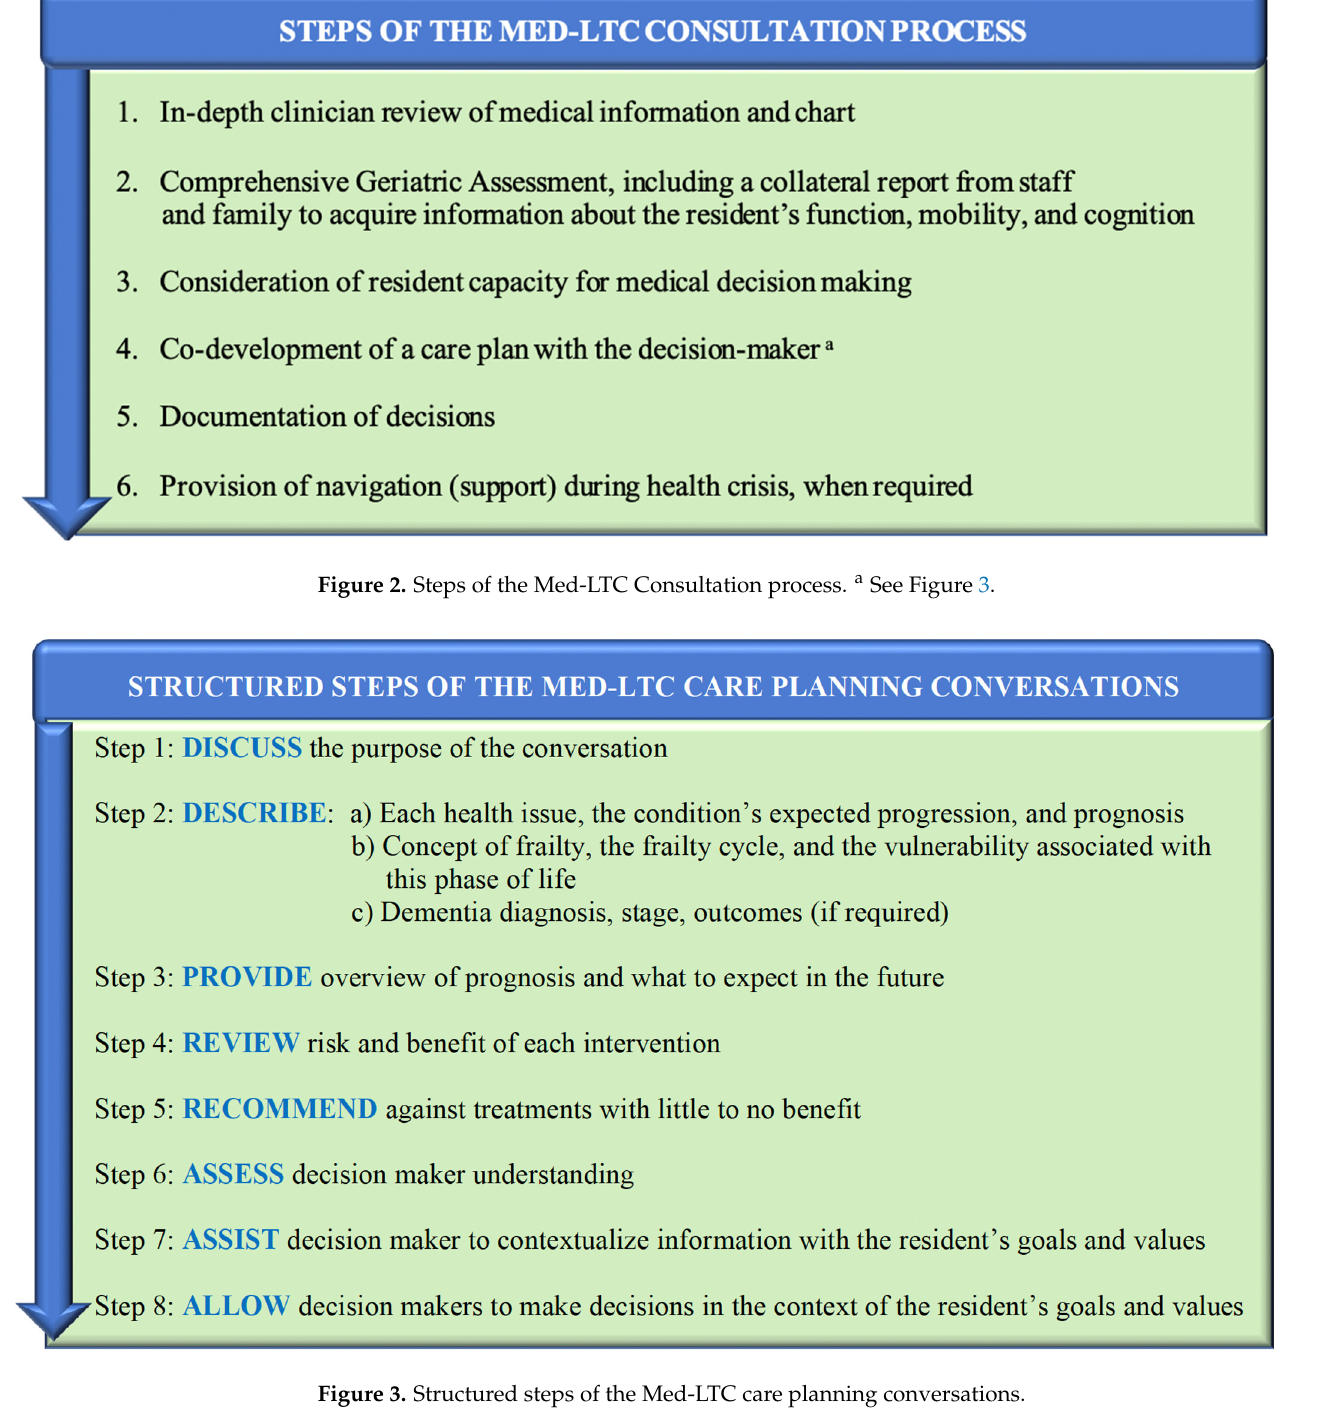
Figure 3. Structured steps of the Med-LTC care planning conversations.